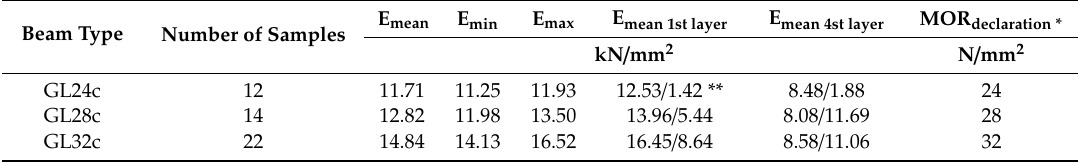
Table 1. Elastic properties of designed beams.